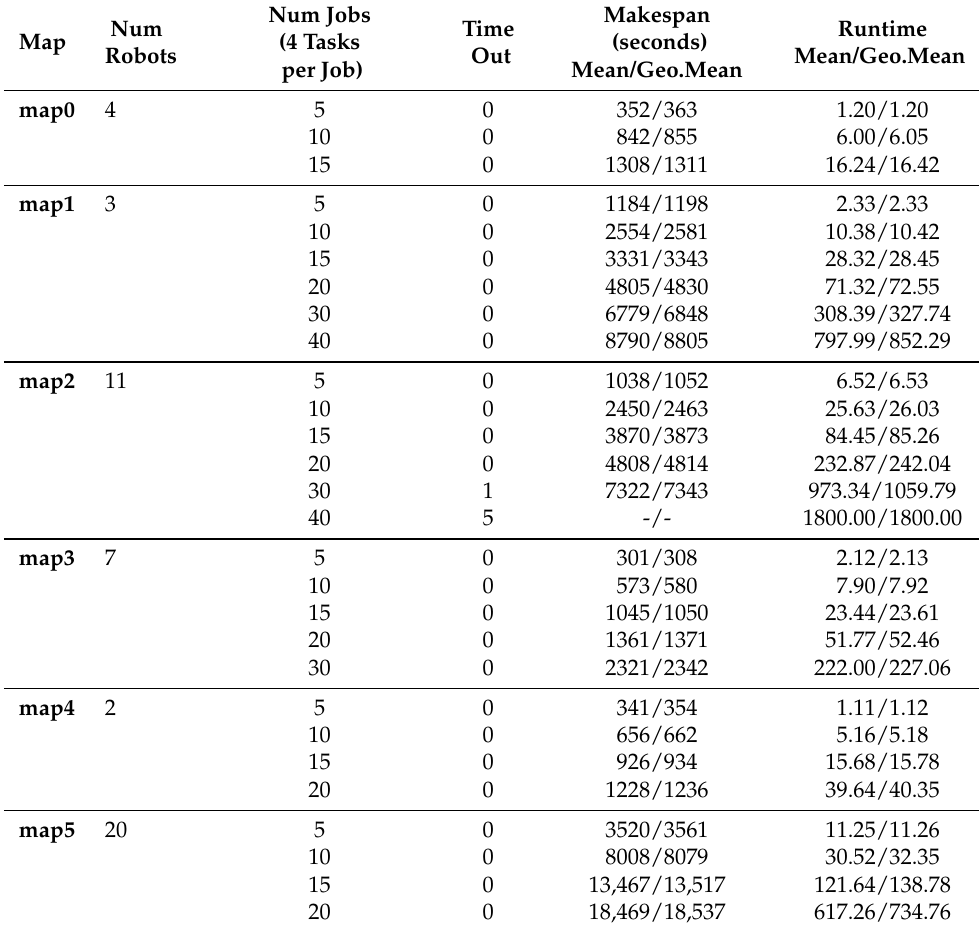
Table 7. Comparison of runtimes and makespans by map and and number of tasks for the